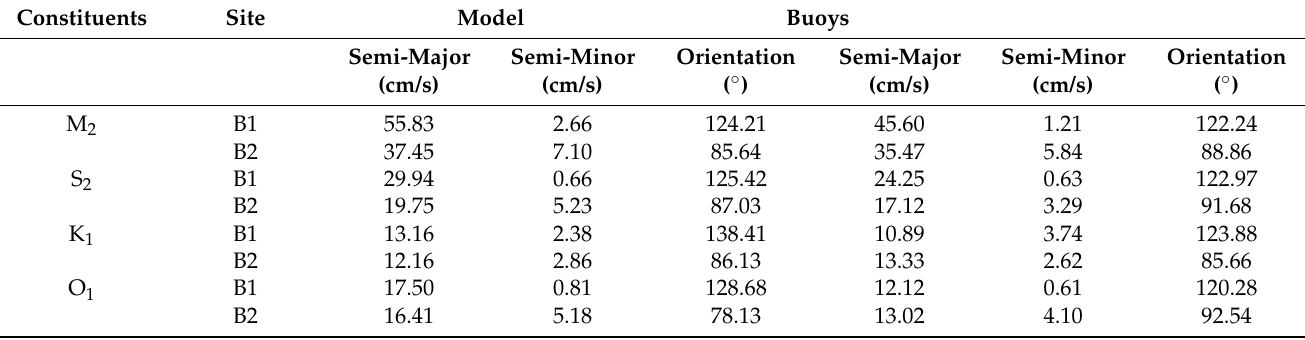
Table 2. Statistics of buoy-derived and model tidal ellipses for M 2 , S 2 , O 1 , and K 1